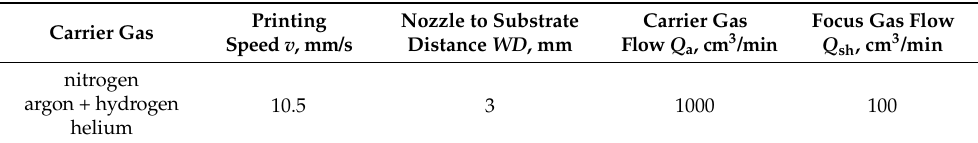
Table 1. Parameters of the formation of structures in the form of pads on ceramic substrates by dry aerosol